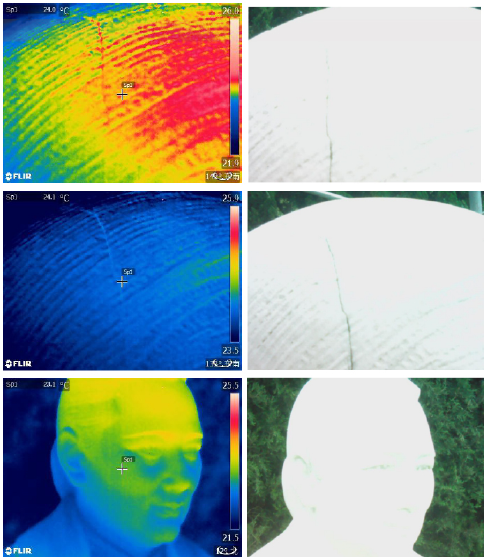
Figure 5 . Comparison of IRT images and real photos of the statue’s head. (Source: Tongji-ACL)